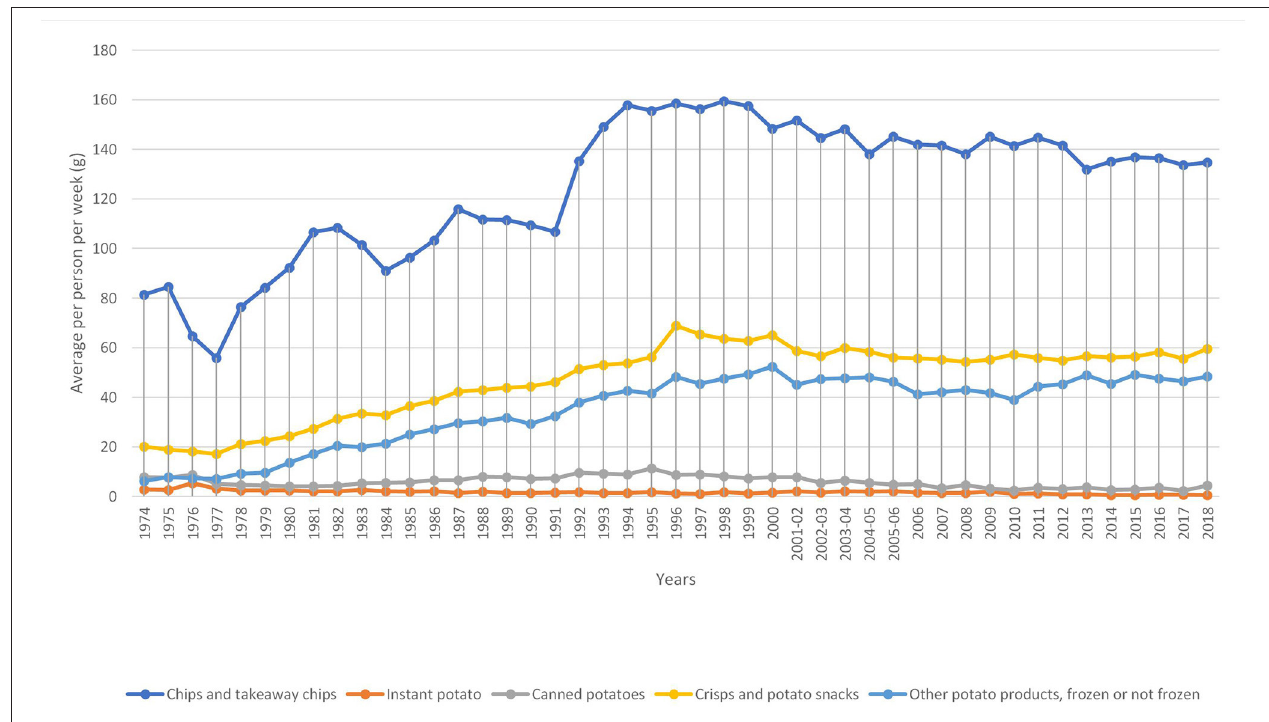
FIGURE 12 | Average weekly consumption of different types of processed potato products in the UK. Source: Own elaboration based on DEFRA